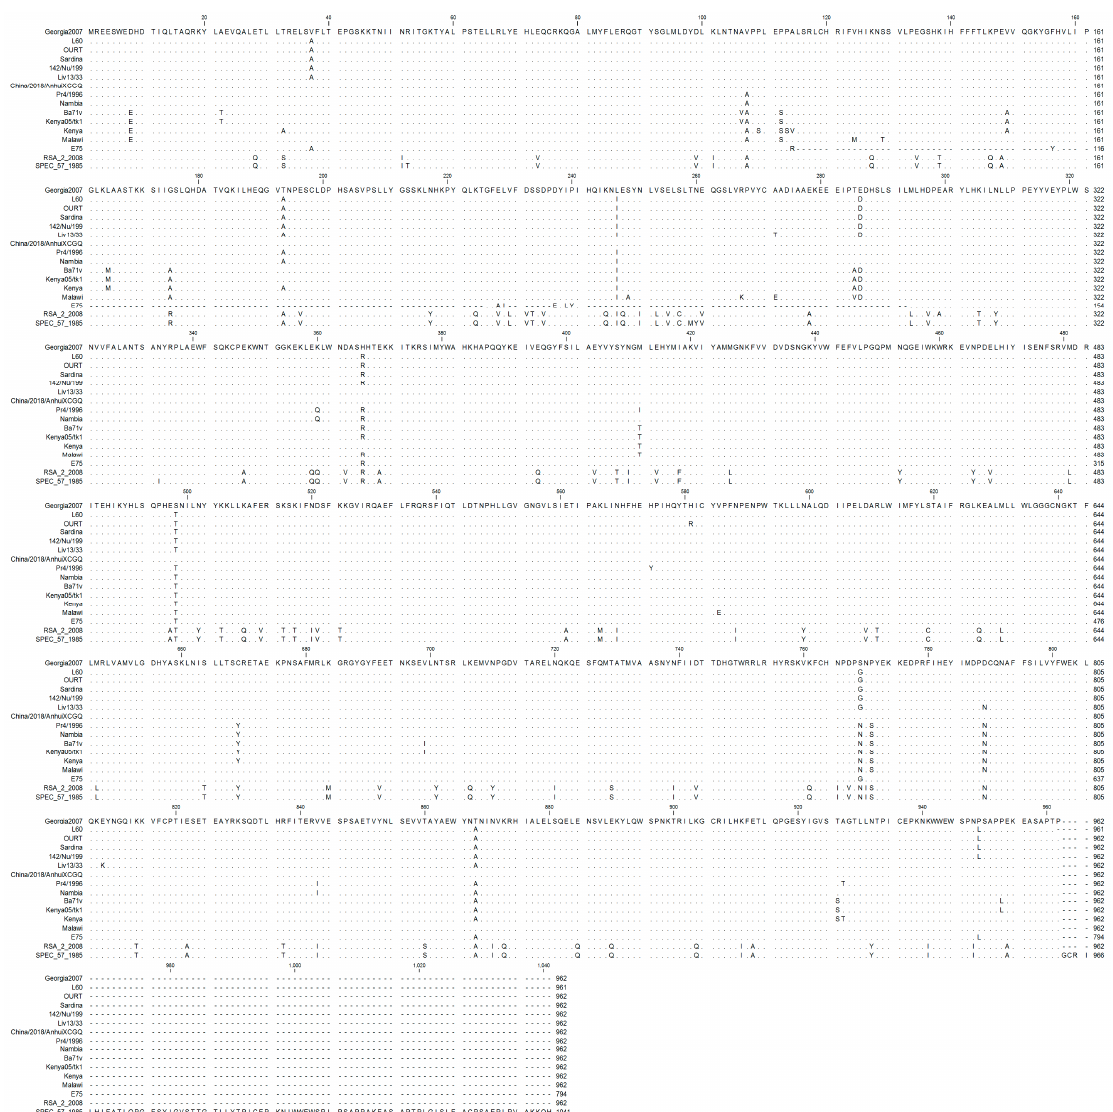
Figure 2. Multiple sequence alignment of the indicated ASFV isolates of viral protein C962R. Matching residues are represented as